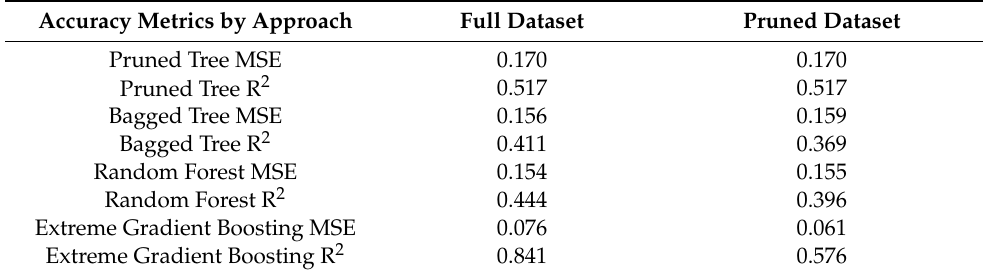
Table 3. Performance of the Models.